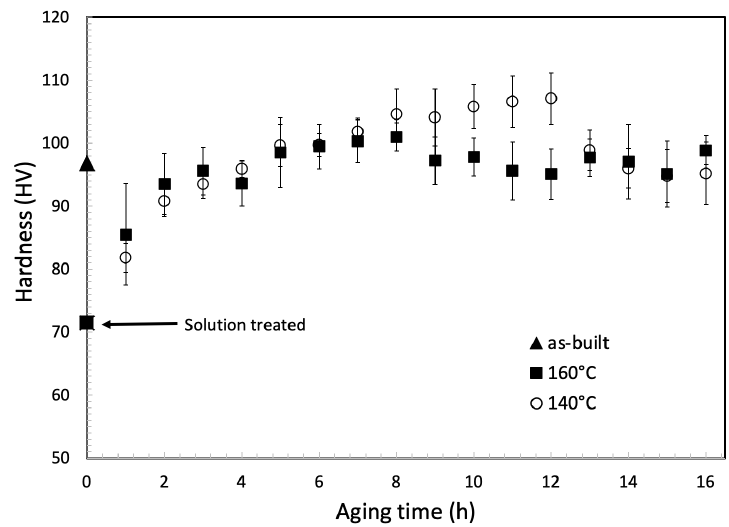
Figure 5. Hardness testing curves obtained for specimens for as-built and heat-treated specimens.